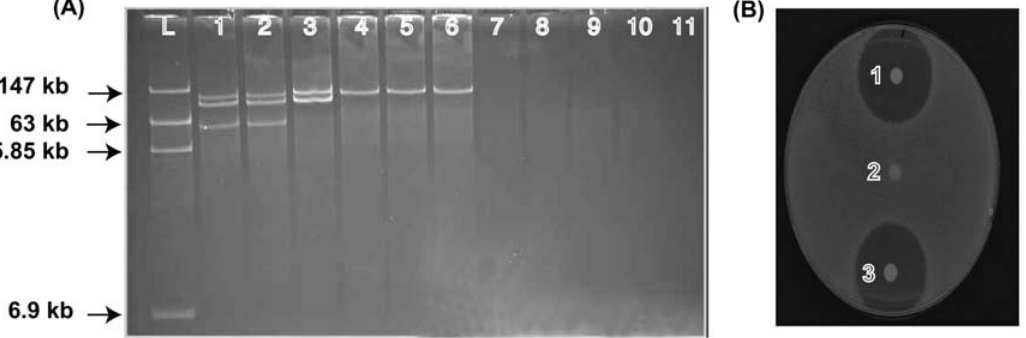
Figure 1. Plasmid profiles of strains on 0.5% agarose gel (A). Four plasmids (147 kb, 63 kb, 35.85 kb, and 6.9 kb) of the strain 39R681 [83] were used as a ladder (L). Each lane contained plasmids from the following bacterial strains: (1) x 7122, (2) x 7273, (3) x 7277, (4) 7345, (5) 7346,